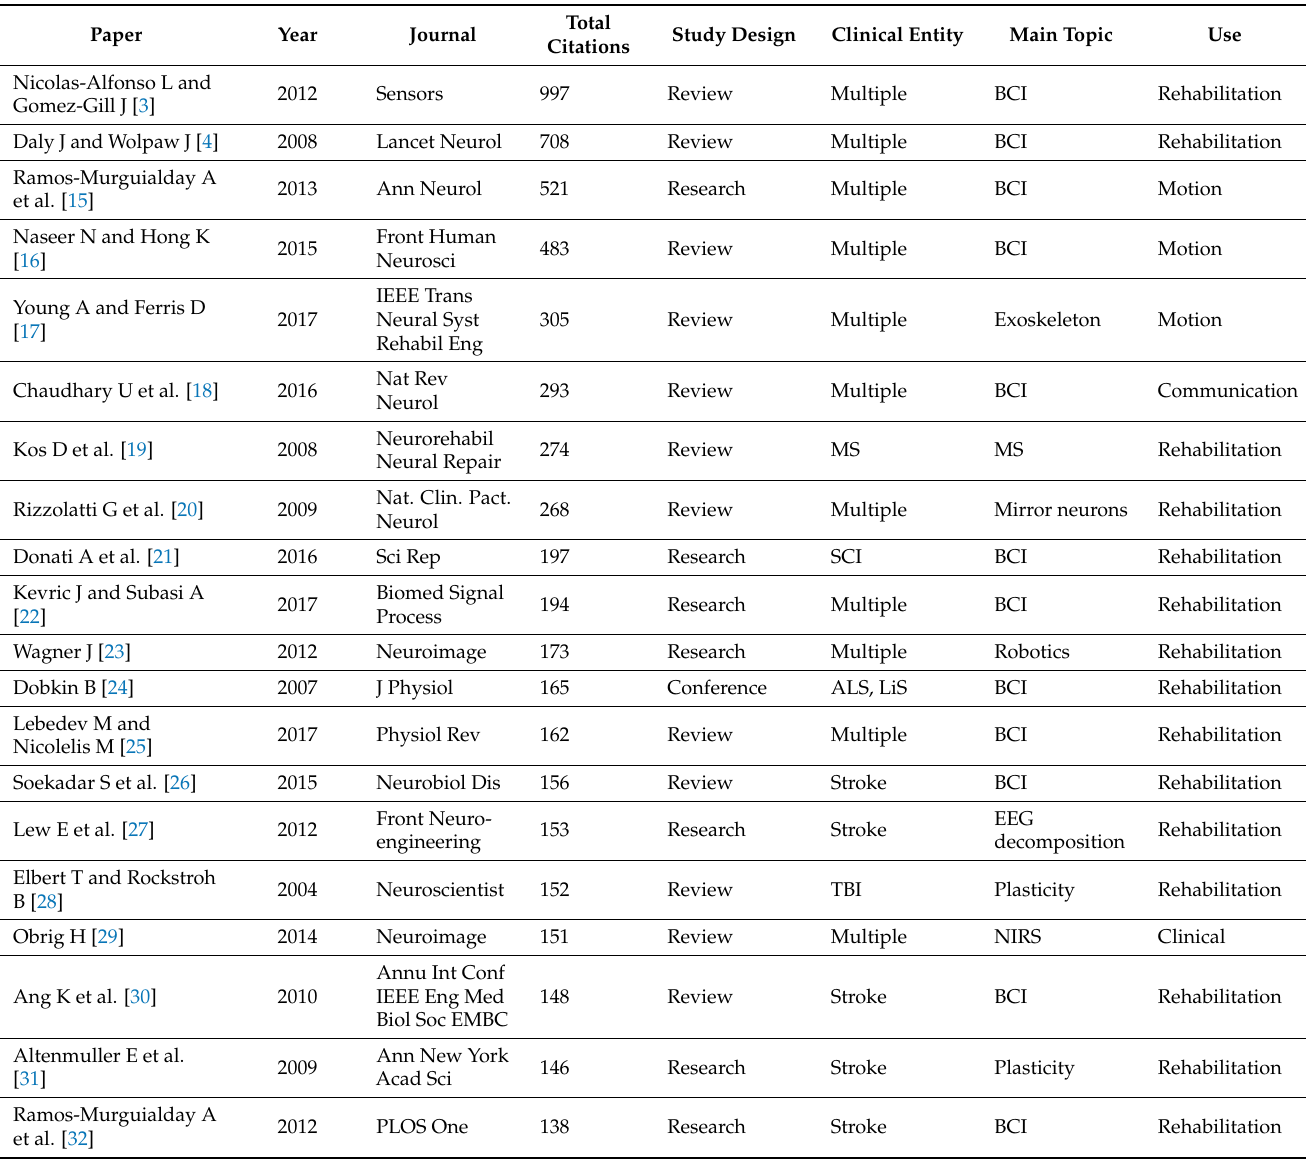
Table 2. Top-20 globally most-cited